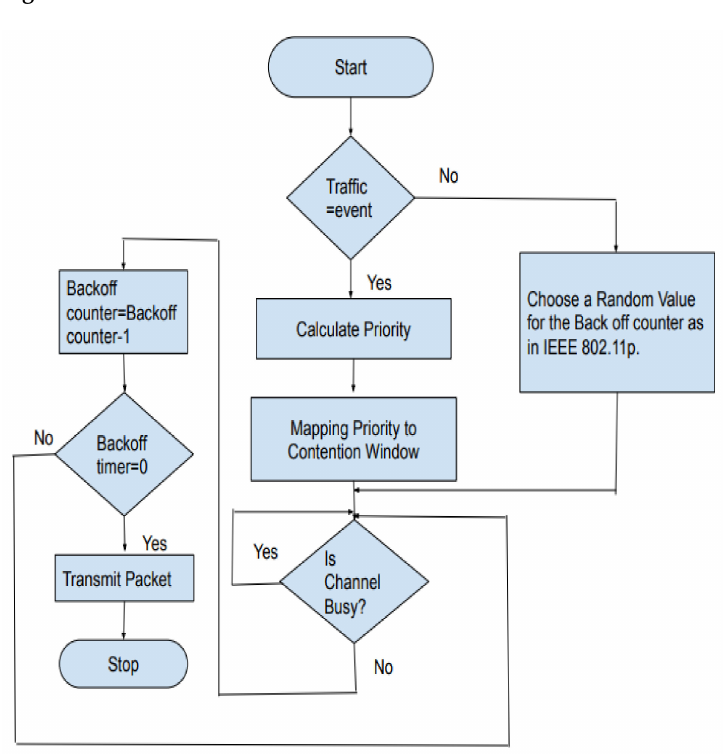
Figure 6. Time Frame.